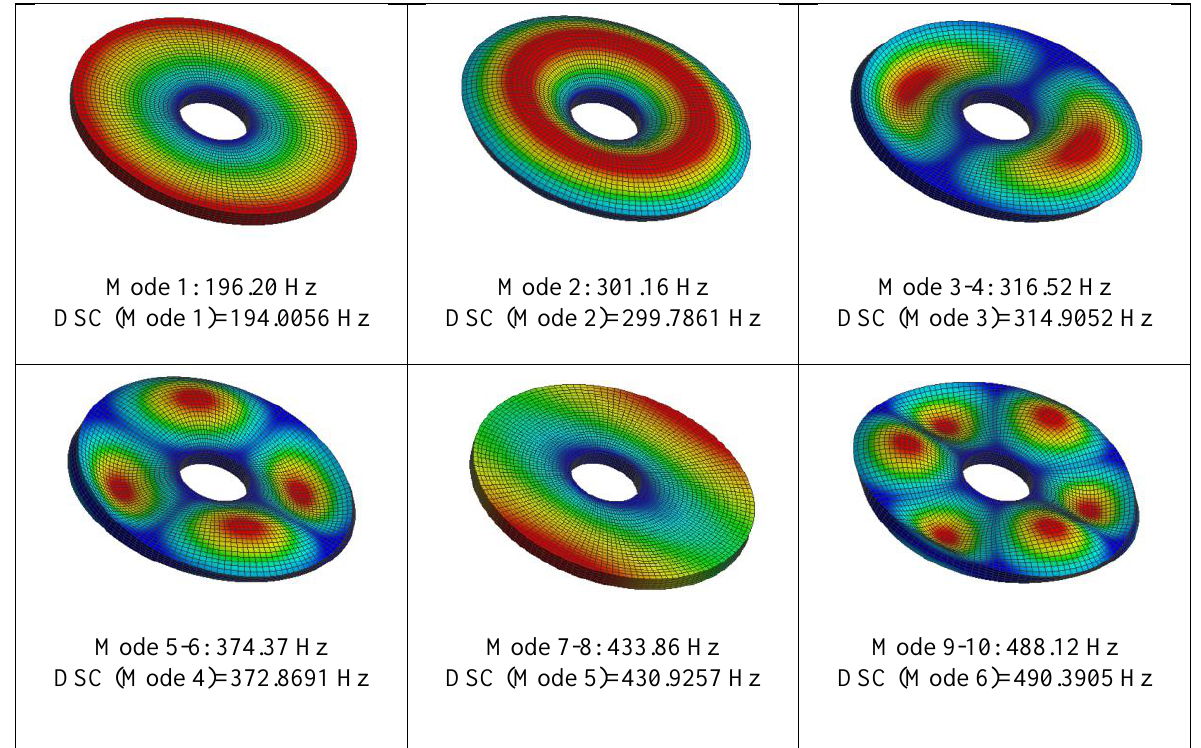
Figure 7: Frequency and mode shapes of thick annular plate with S-C edges (h=20cm, R 1 =50 cm, R 2 =200 cm, ρ =7800 kg/m 3 , E=2.1 × 10 11 Pa, ν